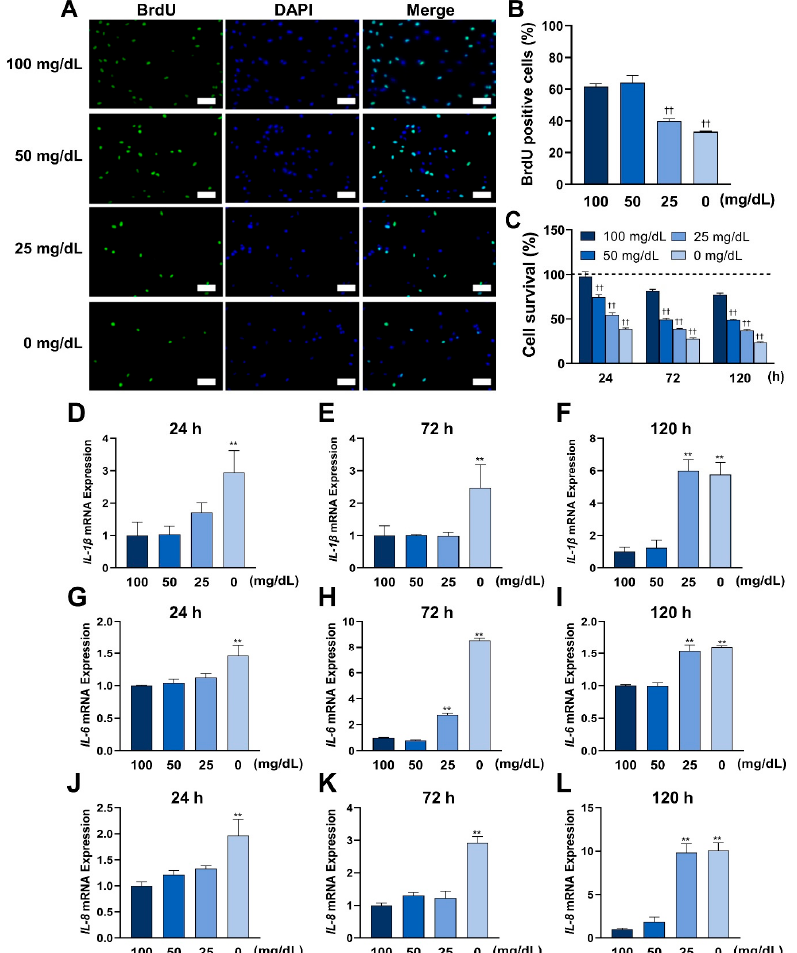
Figure 2. Low glucose conditions affect the cellular viability and promote the expression of inflammatory cytokines in HGnFs. ( A , B ) Representative immunofluorescence images of BrdU were incorporated into DNA, and the nuclei were stained by DAPI. The quantitative analysis of BrdU-positive cells was presented as mean ± SD of three independent experiments. ( C ) Cell survival was measured using an MTT assay. The average of the absorbance of each group at 0 h was used as 100% to calculate the relative results. ( D – L ) The mRNA expression of inflammatory cytokines, such as IL-1 β , IL-6, and IL-8, was determined using real-time PCR in stimulated HGnFs incubated for 72 h. (Scale bars: 100 µ m; a significant increase compared with the control was described as ** p < 0.01; a significant decrease compared with the control was described as †† p <